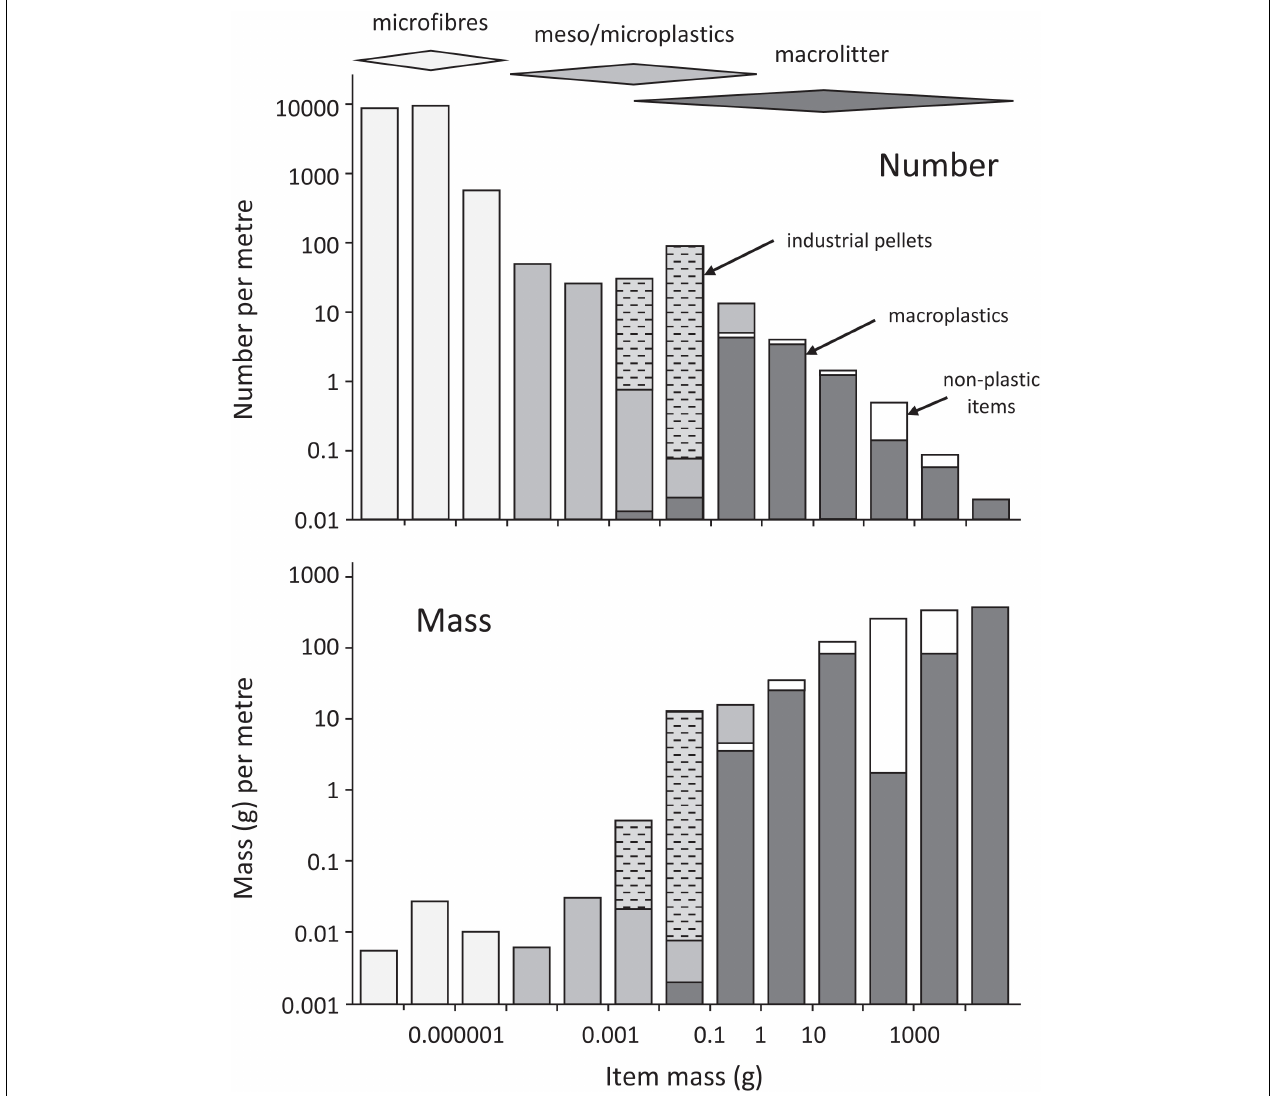
FIGURE 4 | The contributions of macro-, meso, and micro-litter samples to the abundance and mass of plastic litter per meter of beach in the West Coast National Park, South Africa, pooling data from 2010 and 2017. Note log scales on both axes in both panels, but shading within each size class shows the proportional contribution of each litter class. Horizontal dashed lines = industrial pellets; white = non-plastic